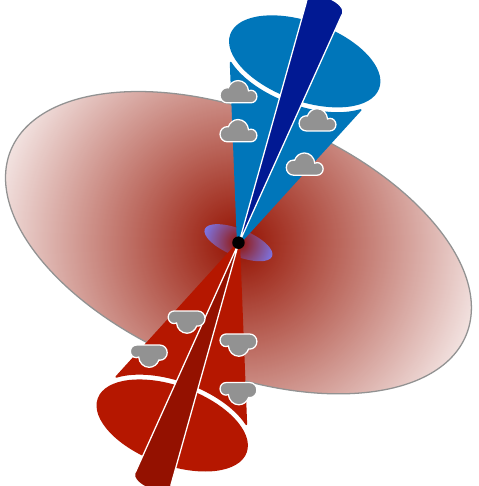
Figure 5. Cartoon showing a nested biconical structure in the outflow (that is blue-shifted when approaching and redshifted when receding as denoted by the colors) in order to reproduce the double-peaked emission line AGN spectroscopic observations. The host galaxy (red ellipse) and accretion disk (blue ellipse) as shown here are not to scale. The outer layers of a jet or a wind could be driving the NLR gas